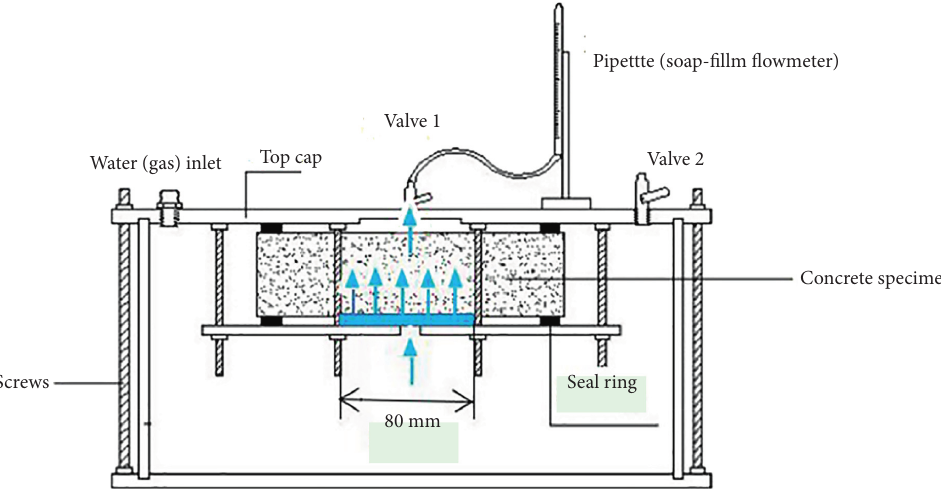
Figure 3: Principle for testing permeability of concrete.